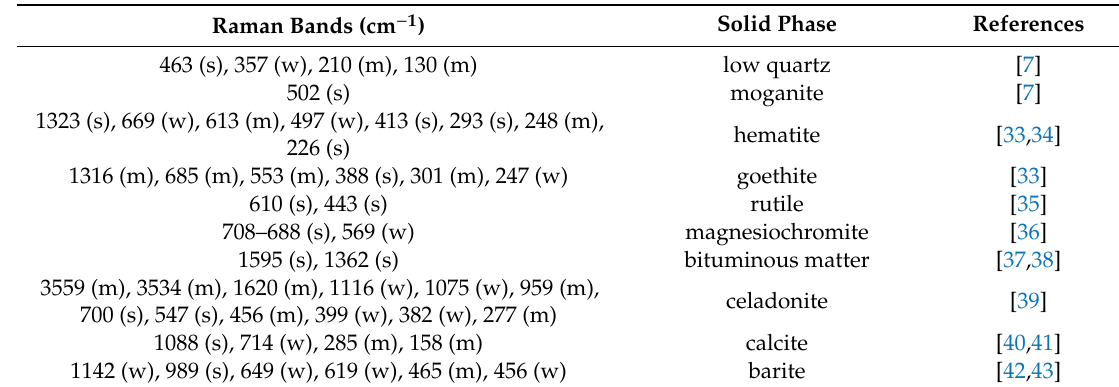
Table 1. Example of the Raman spectra for all identified minerals.